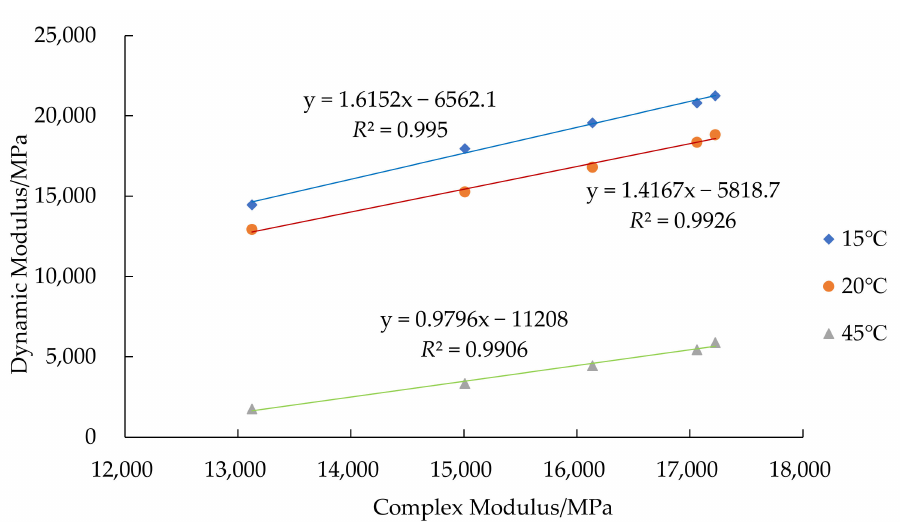
Figure 8. EME-14- France